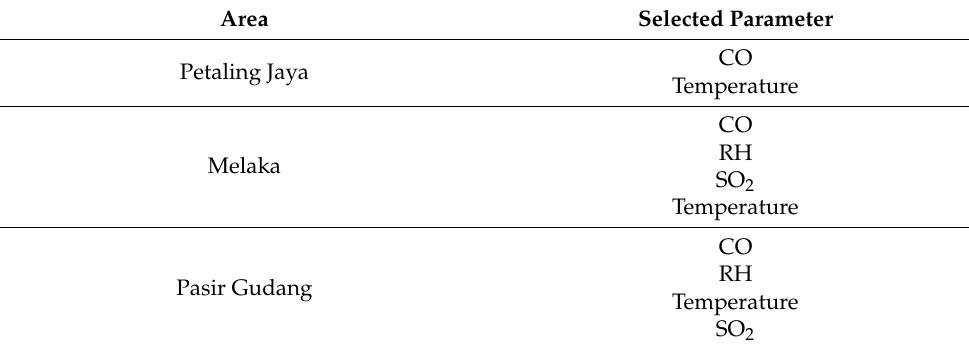
Table 6. Selected parameters for modified QR (Pearson–QR) model.